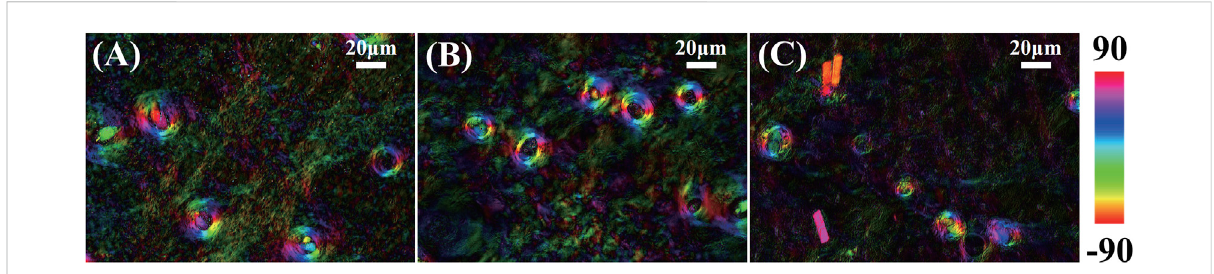
FIGURE 4 Polarization staining image of three mouse skin tissue samples, (A) sample 1, (B) sample 2, and (C) sample 3. Here, the intensity encoded by parameter δ describes the linear retardance value, and the hue encoded by parameter θ shows the fast axis orientation of the linear birefringent